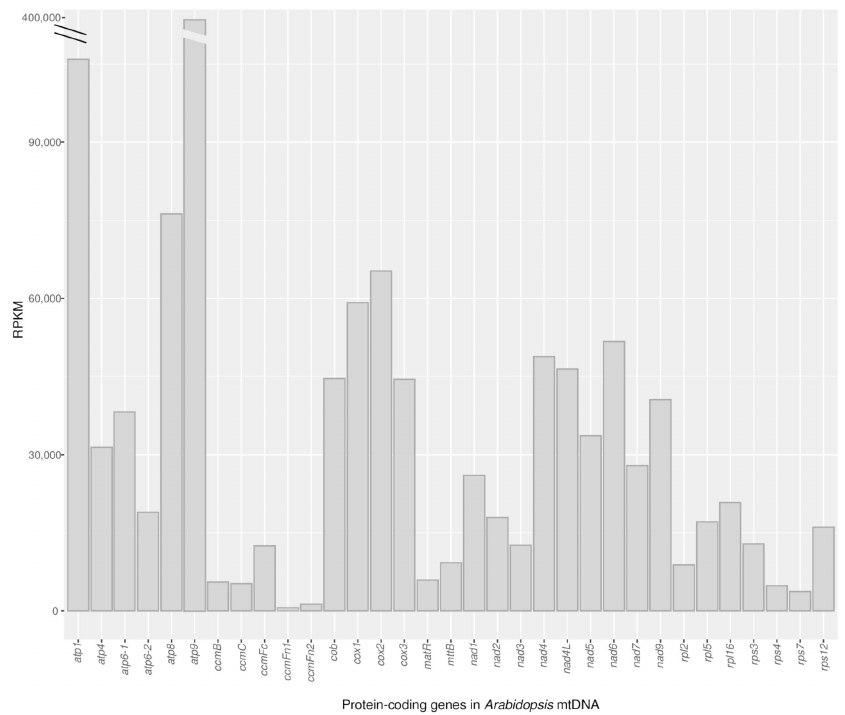
Figure 1. RPKM of the coding regions of protein-coding genes based on the combined RNAseq data sets of the three biological samples. The interrupted RPKM for atp9 is